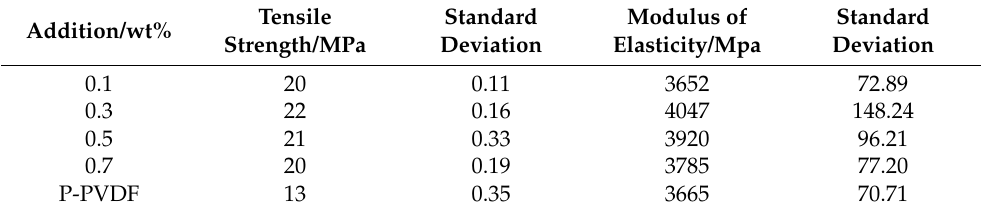
Table 5. Mechanical properties of the fiber membrane at different loading of AgNO 3